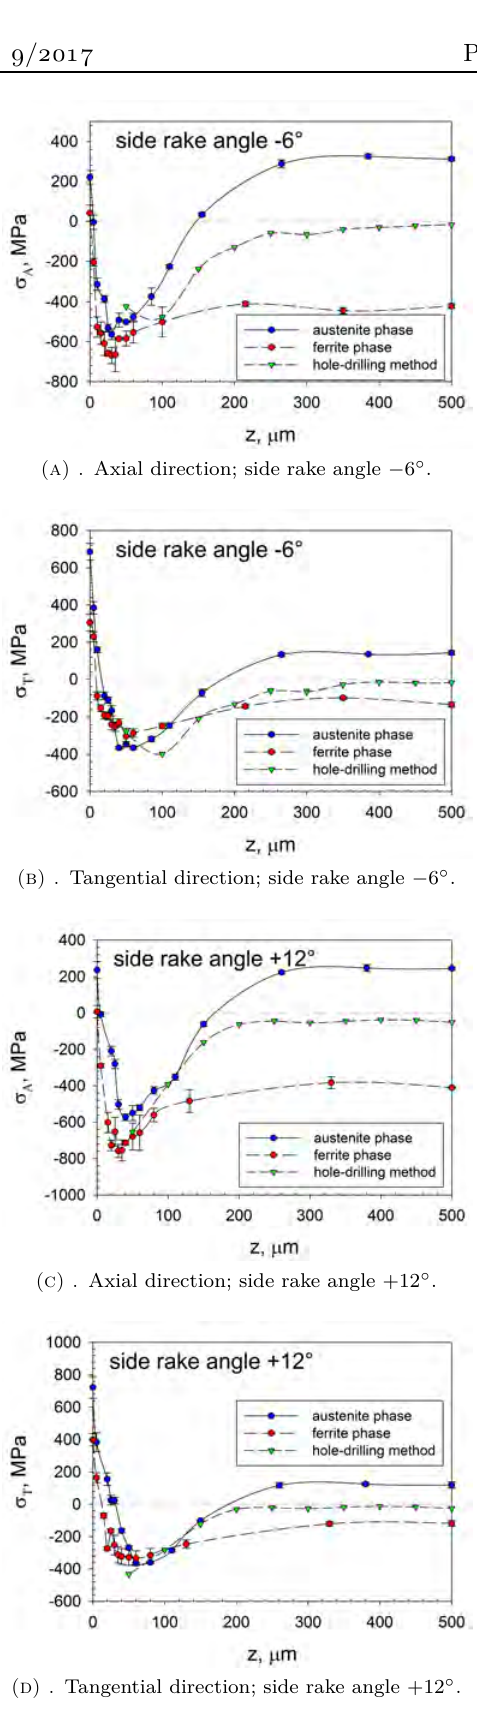
Figure 4. Residual stress gradients σ mined by XRD and hole-drilling